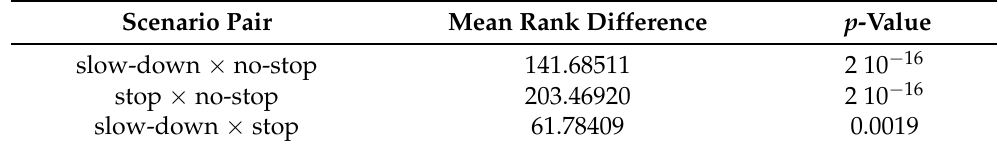
Table A4. Results of the Dunn pairwise test on the NO x